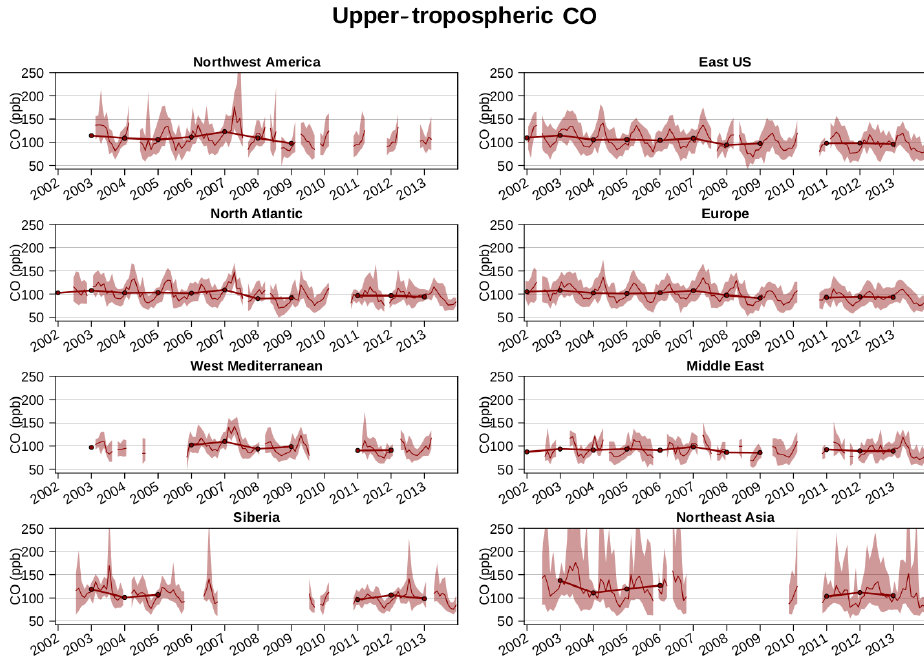
Figure B4. CO monthly mean values in the UT (thin curve). The interval from 5th and 95th percentiles is filled in red. The yearly mean values are represented by the bold curve and the black